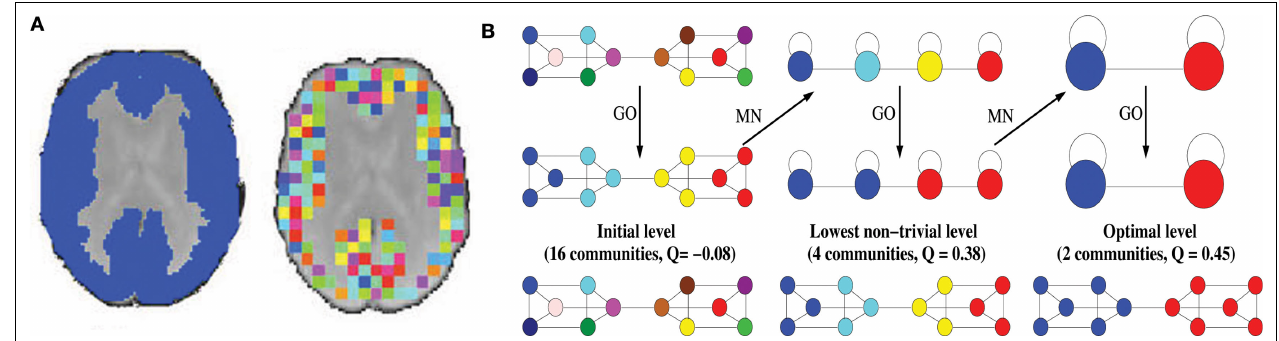
modularity (typically, the community of the neighbour for which the increase is maximal is chosen). The second phase builds a meta-network (MN) whose nodes are the communities found in the fi rst phase. We denote by “pass” a combination of these two phases. The passes are repeated until no improvement of modularity is possible and the optimal partition is found. When applied on this graph, the algorithm fi rst fi nds a lowest non-trivial level made of four communities. The next level is the optimal level and is made of two